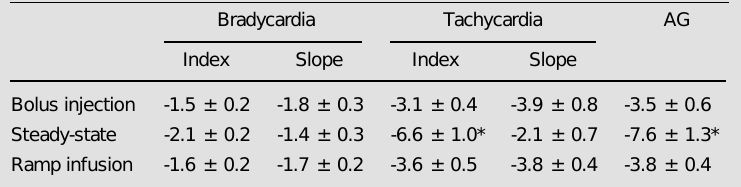
Table 1 - Sensitivity of the baroreflex control of heart rate calculated by mean index (Index), linear regression (Slope) and logistic function (AG) when the blood pressure was changed by bolus injection, steady-state and ramp infusion of vasoactive drugs. *P<0.05 (two-way ANOVA-Bonferroni